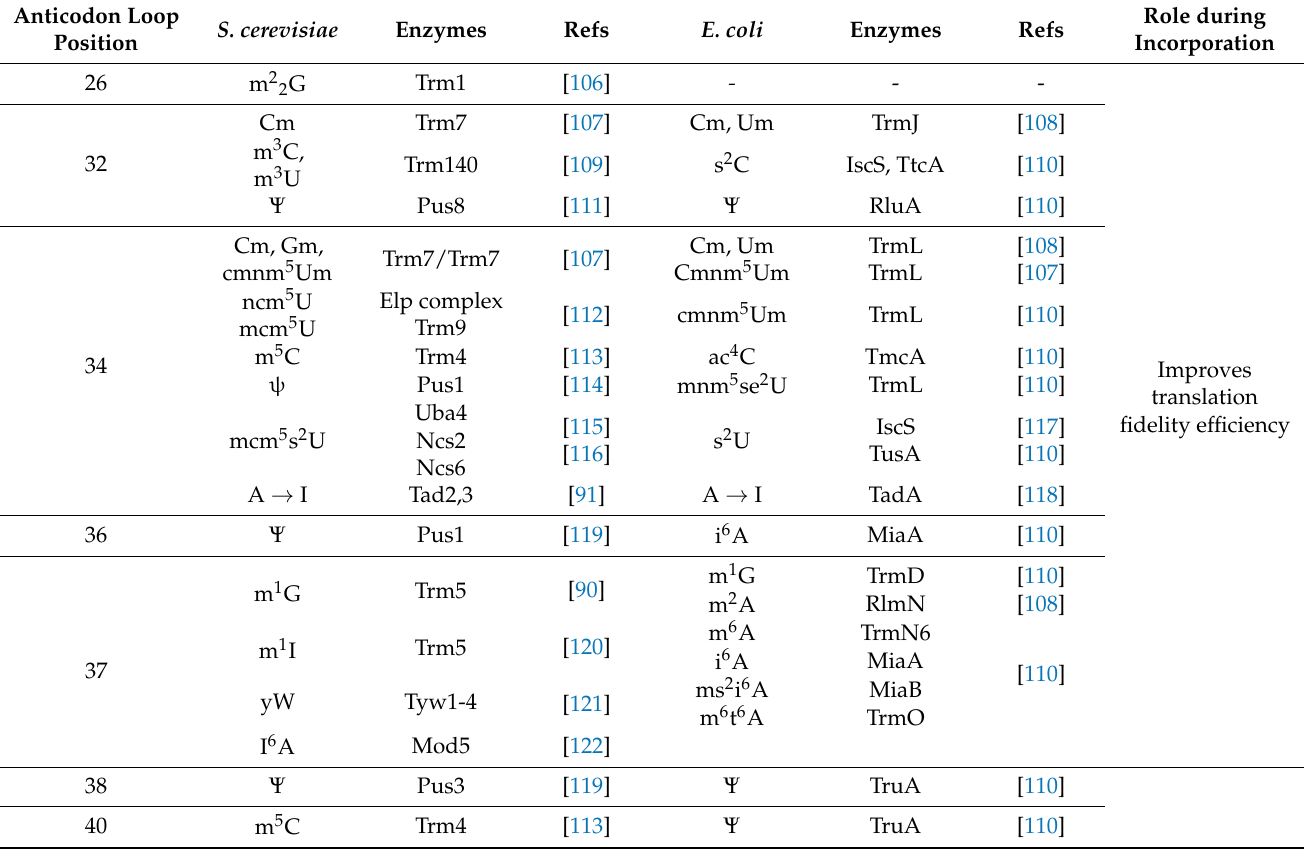
Table 2. tRNA modifications in the anticodon stem in Saccharomyces cerevisiae and Escherichia coli and the respective modifying enzymes to be manipulated for the improvement of ncAA incorporation